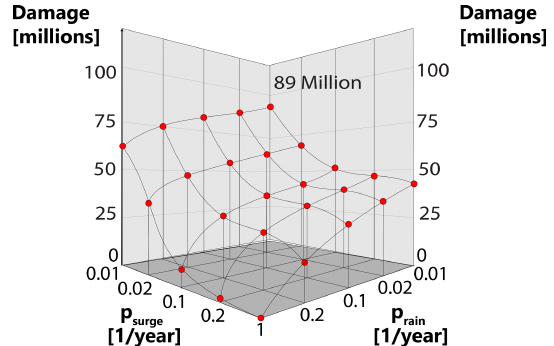
Figure 7. Risk profile of the current situation in Beira, Mozam- bique. Shown is the expected damage of a compound flood event with a probability of occurrence of the storm surge ( p s ) and the rainfall ( p r